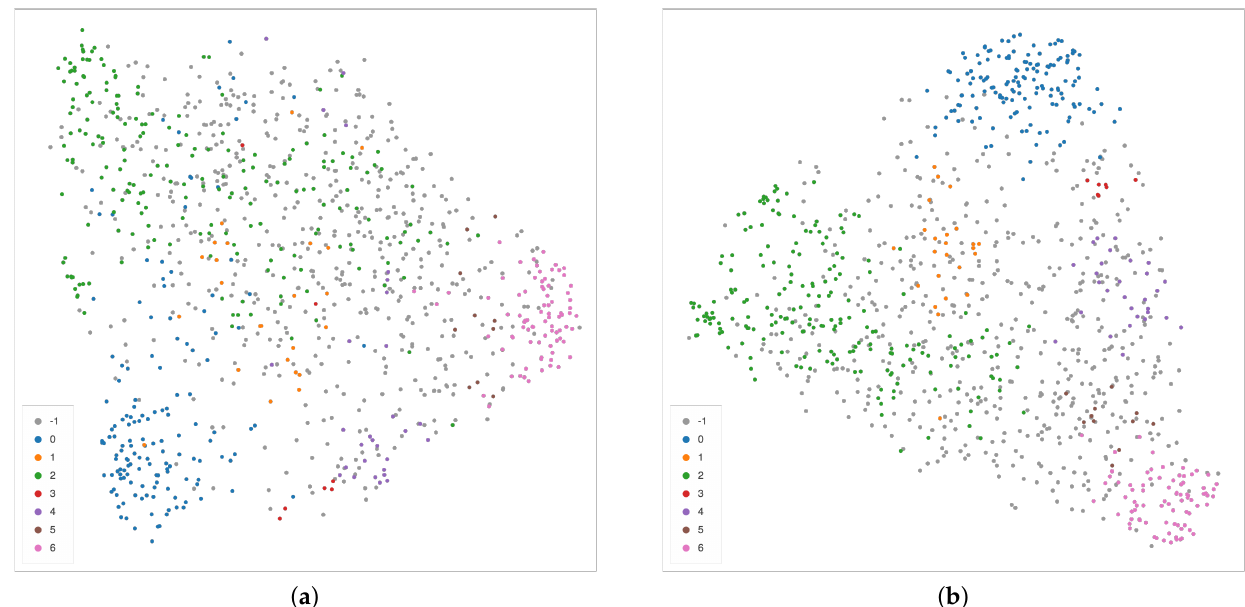
Figure 14. Alternative UMAP 2-dimensional embedding on the features extracted from the second layer of the decoder path of the EUNet network, with L 1 ( a ) and L 2 ( b ) metric. Colors correspond to the detected clusters.